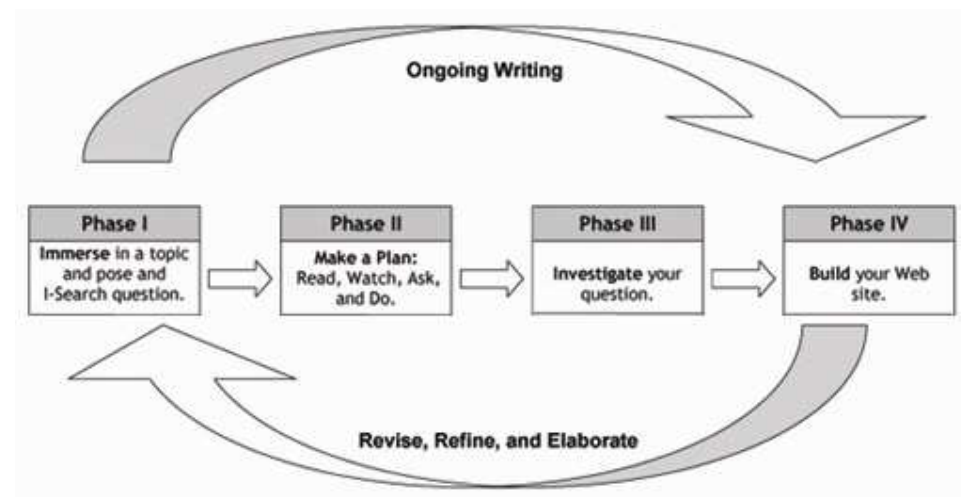
Figure 1 Phases of the I-Search